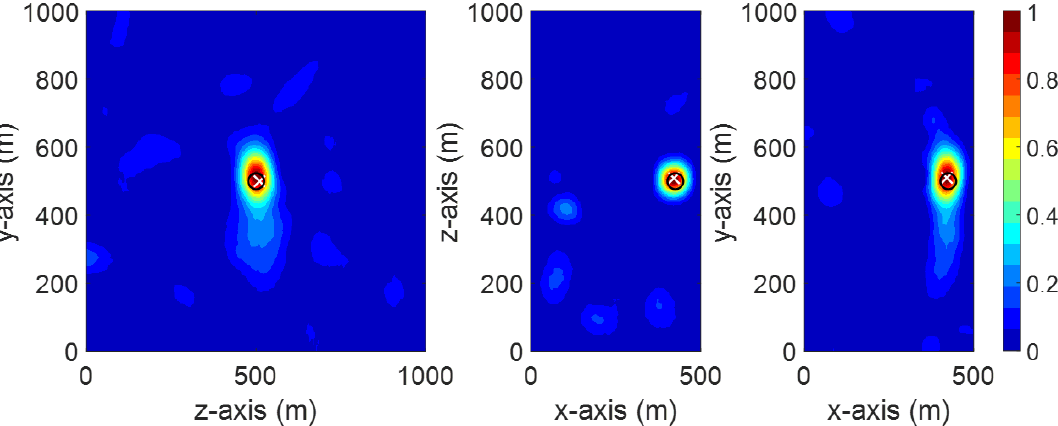
Figure 11. Normalized distribution of the electric field power at the optimal time slice provided by the entropy criteria.